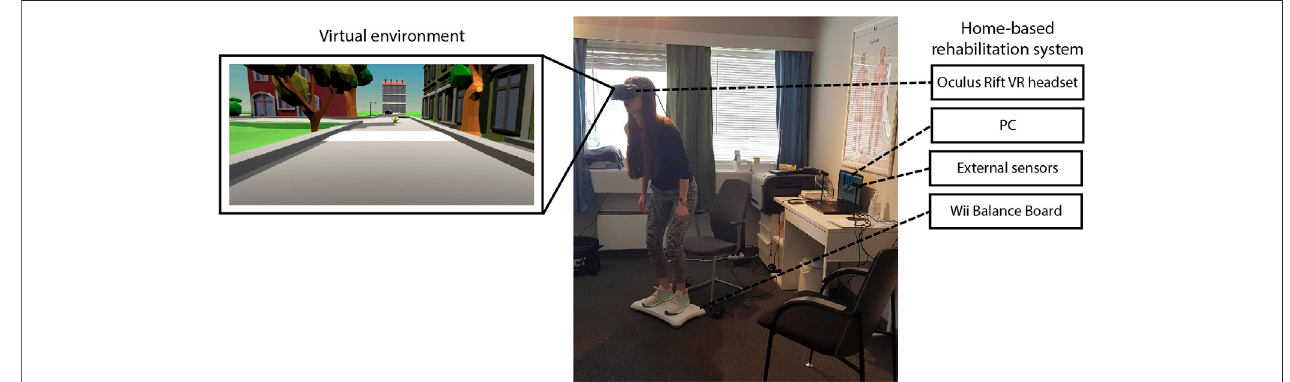
FIGURE 4 | Home-based system.